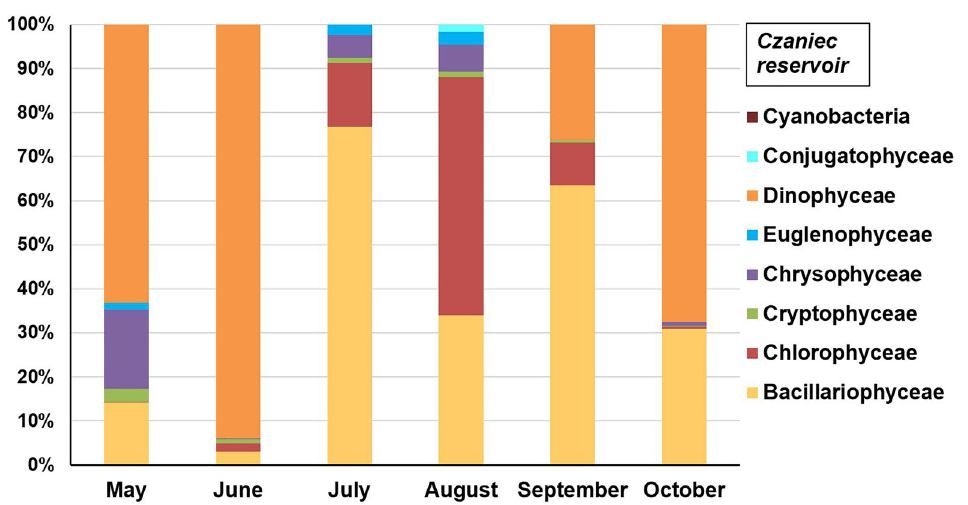
Figure 7. Structure of planktonic algae groups in the Czaniec Reservoir in 2019